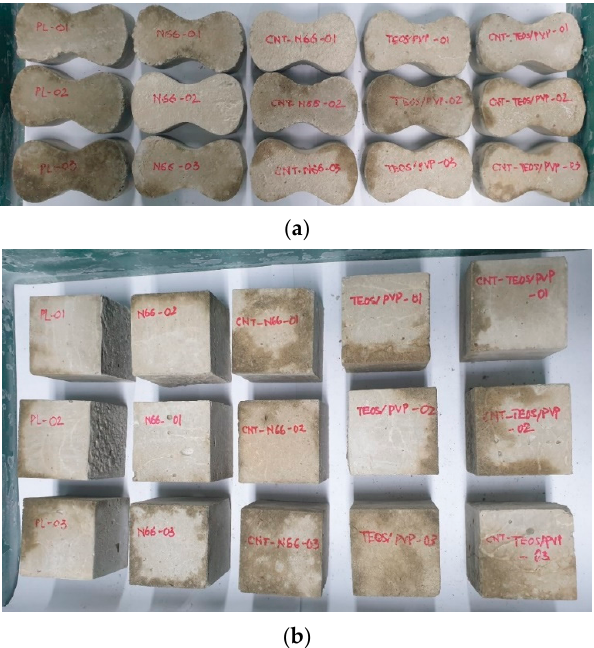
Figure 2. Samples for mechanical strength tests: ( a ) briquette samples; ( b ) cubic samples.